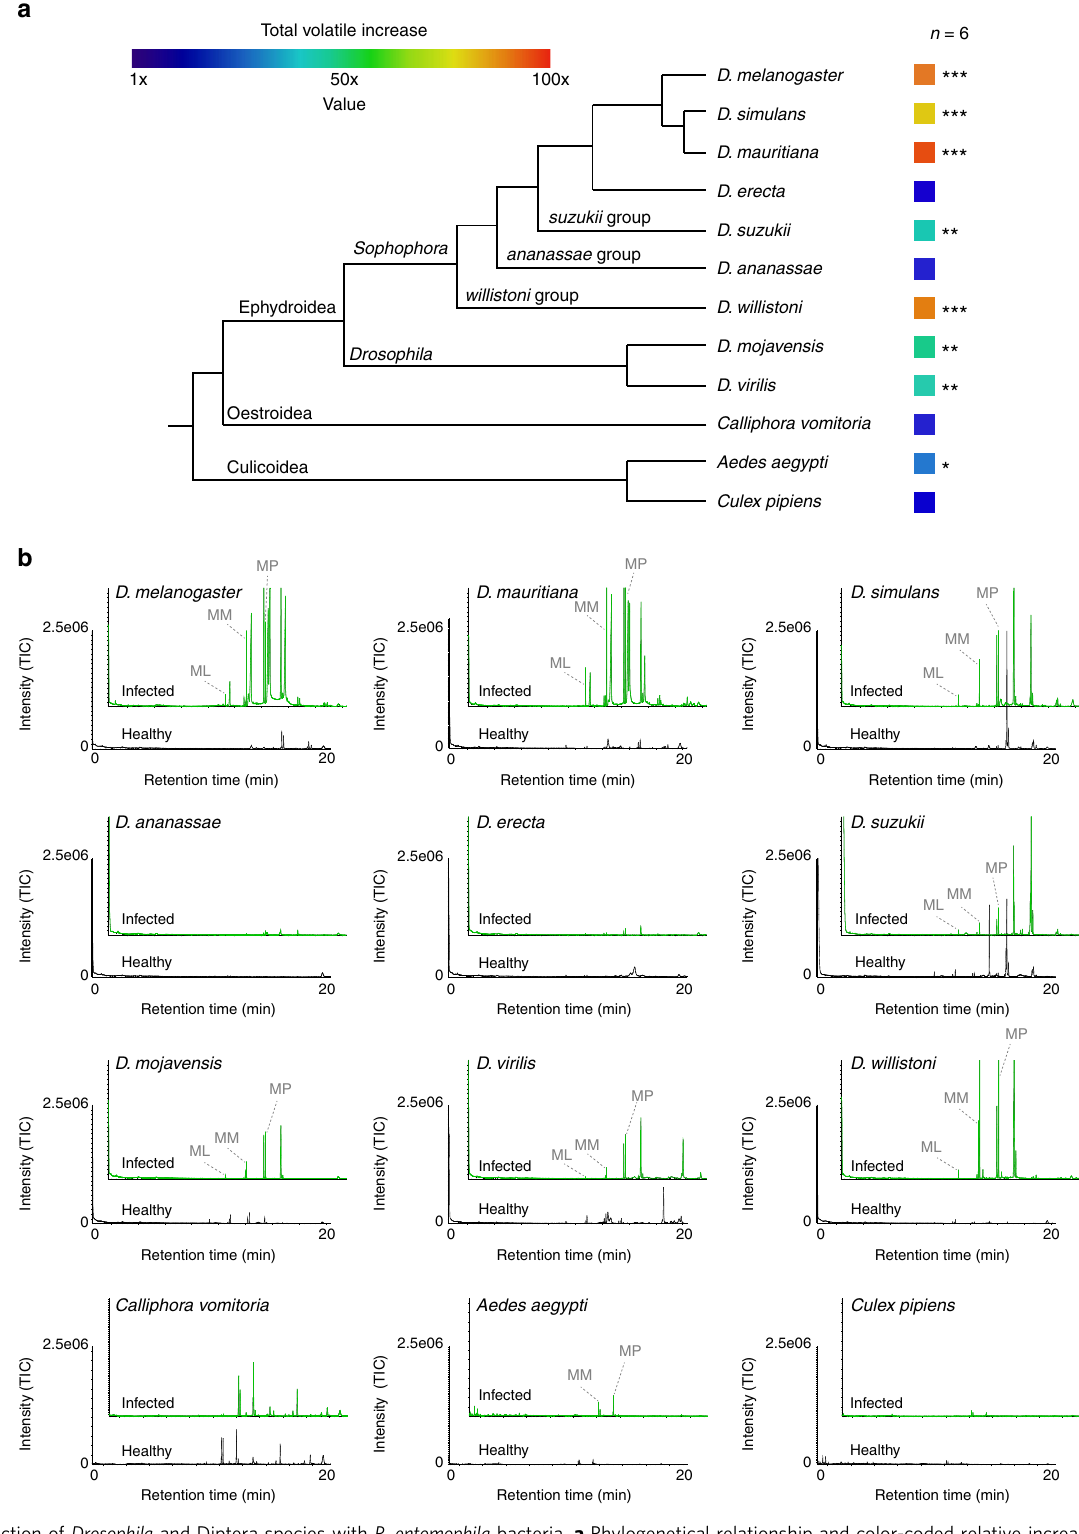
Fig. 4 Infection of Drosophila and Diptera species with P. entomophila bacteria. a Phylogenetical relationship and color-coded relative increase of odor emissions after infection for all tested species. b Example of GC-MS traces for each species before and after infection with P. entomophila bacteria with those methyl esters identi fi ed that were behaviorally relevant in D.